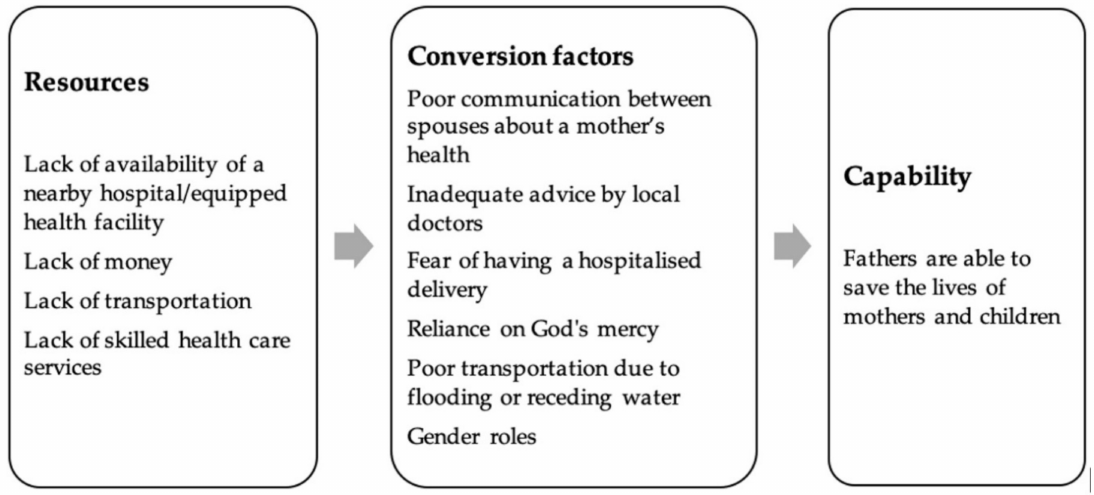
Figure 3. Summary of the findings in light of Capability Framework for Child Growth